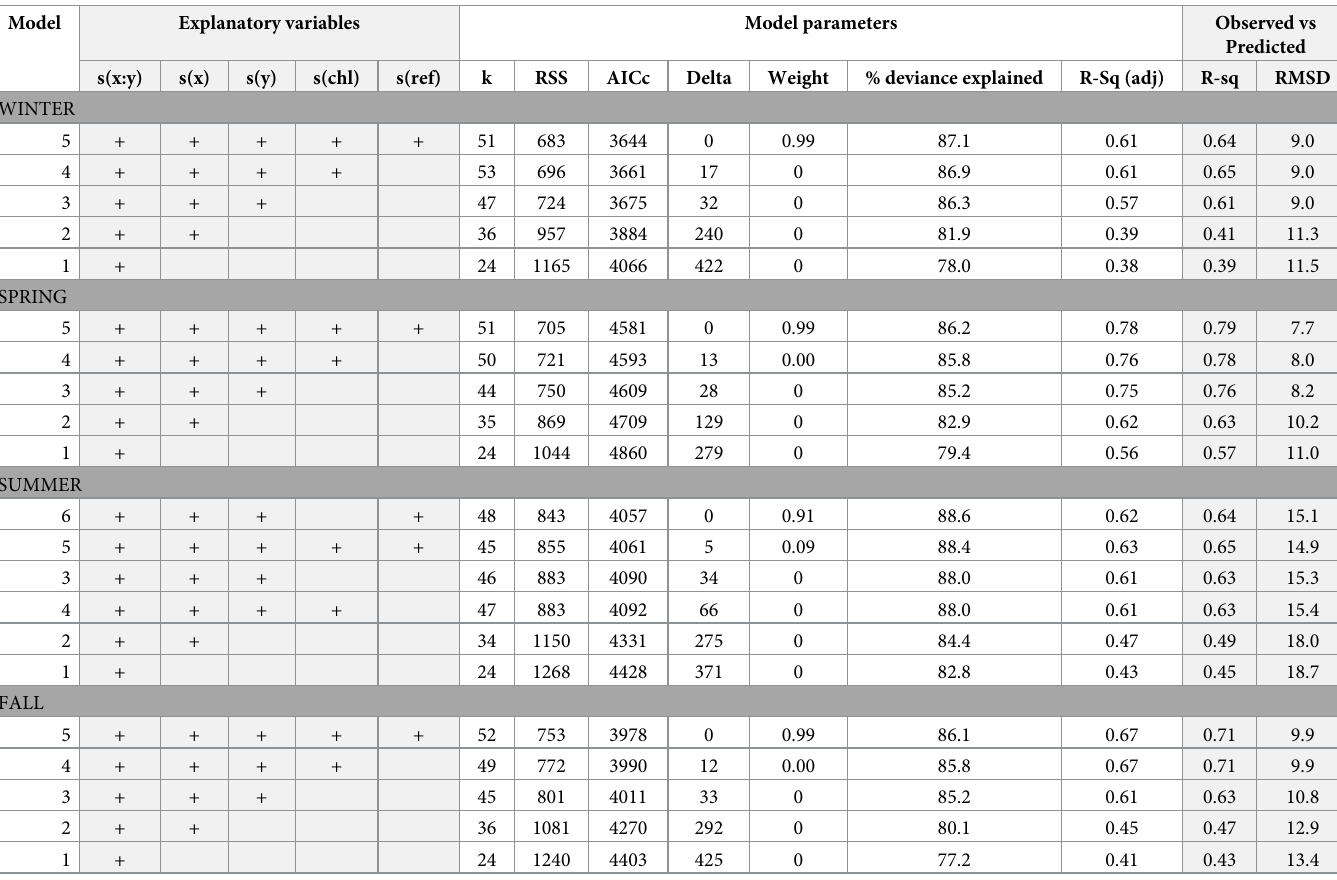
Table 3. Model selection to test for the spatial distribution of offshore recreational boating trips for each season. x = longitude, y = latitude, x:y = interaction between longitude and latitude, chl = chlorophyll a concentrations, ref = reef abundance per sampling unit, and s = thin plate regression spline fit, k = number of model parameters, RSS = residual sum of squares, weights = AIC weights, RMSD = root mean square